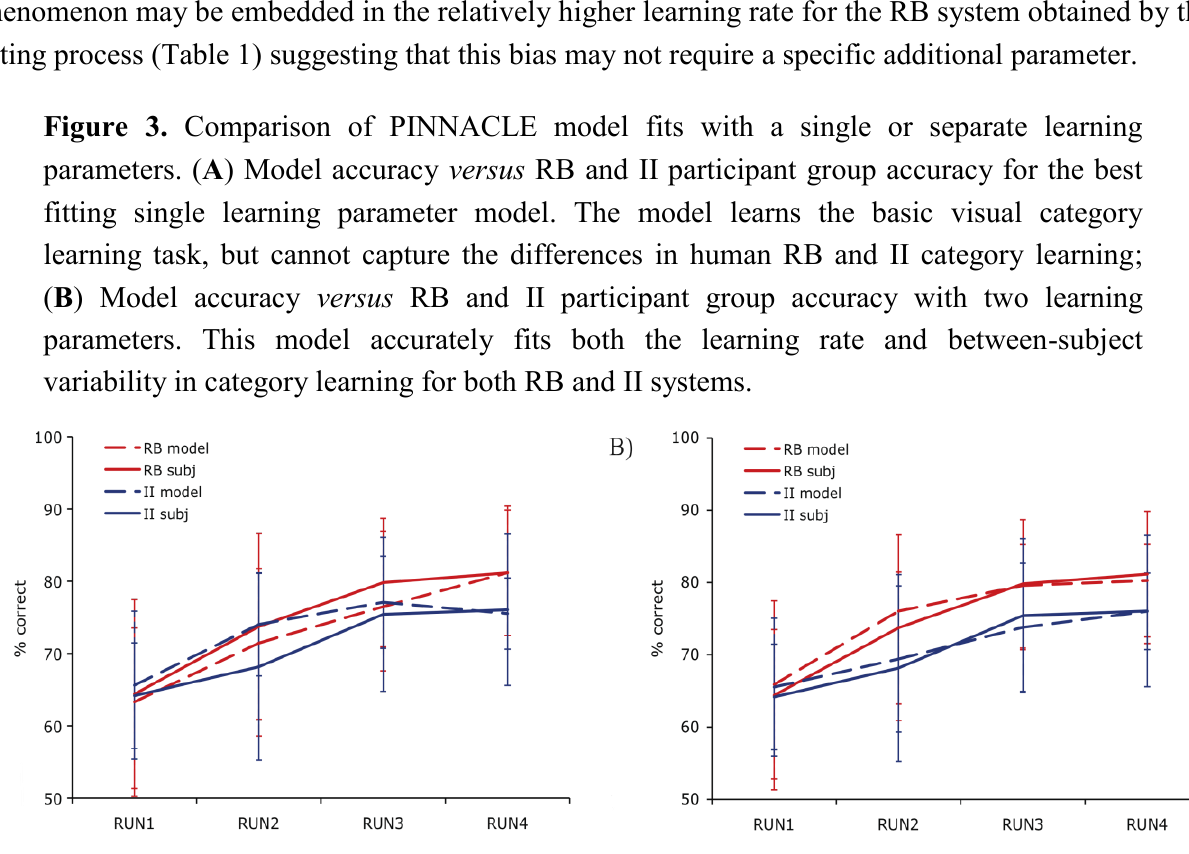
Table 1. Comparison of feedback models (A) 4 parameter model fits (B) 5 parameter model fits. In the following tables, the data is sorted according to fit value (sum